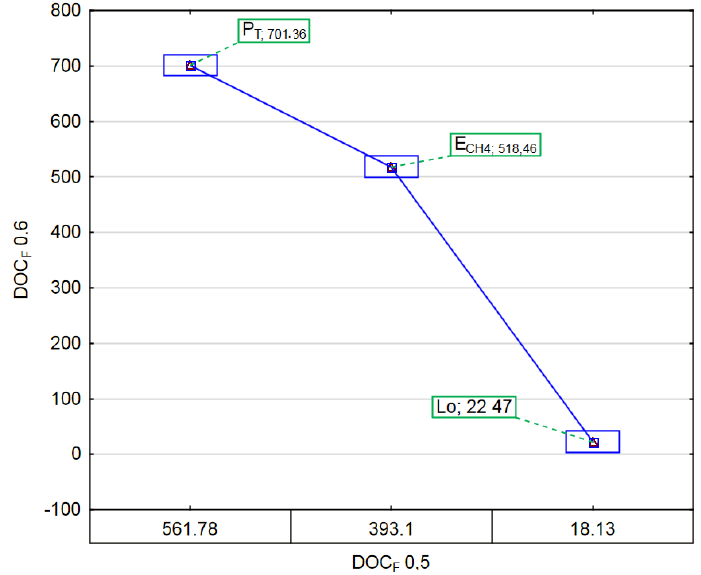
Figure 7. Prediction of DOC F parameter variations.